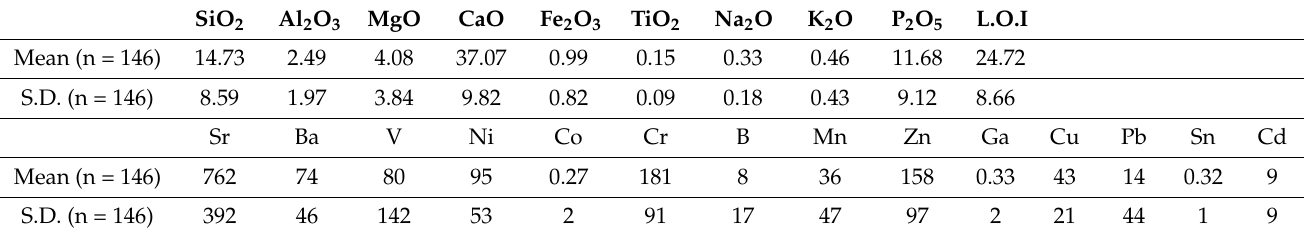
Minerals 2021 , 11 , x FOR PEER REVIEW 11 of 23